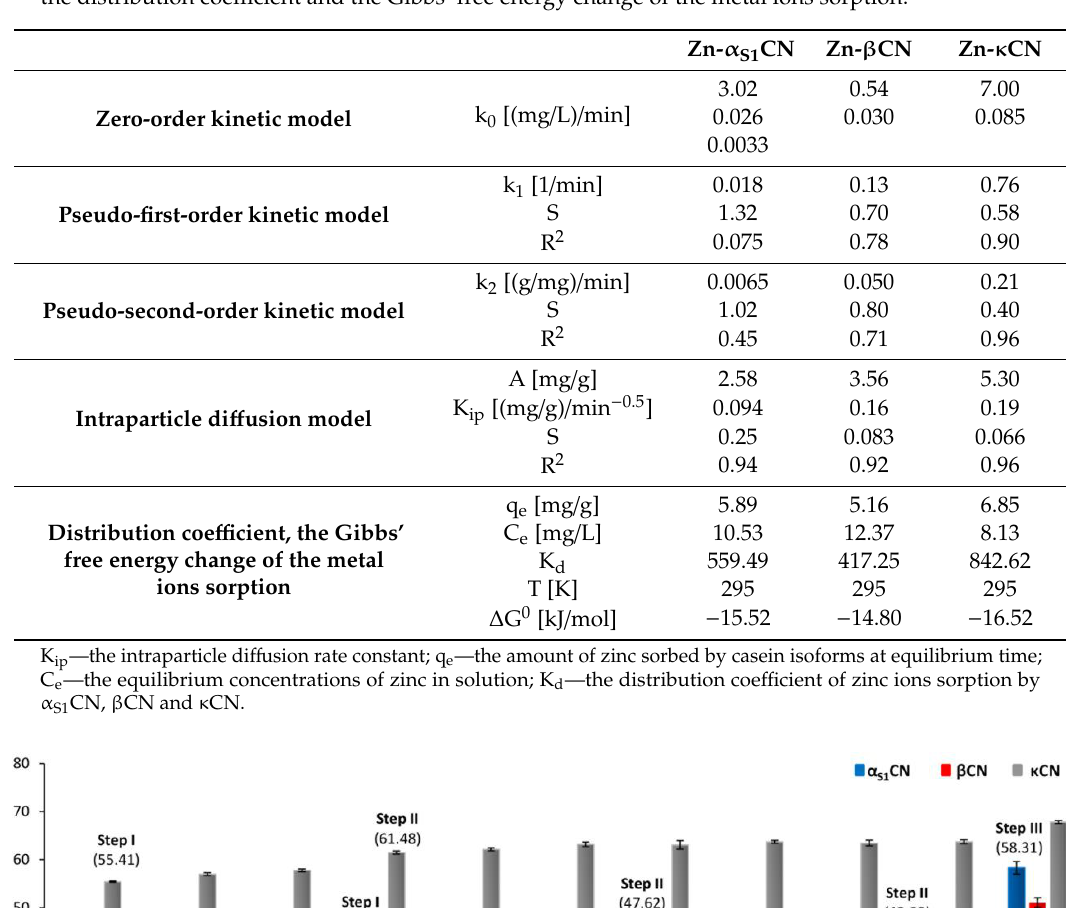
Table 1. Kinetic model parameters for the zinc ions sorption by α S1 CN, βCN and κCN and values of the distribution coefficient and the Gibbs’ free energy change of the metal ions sorption.